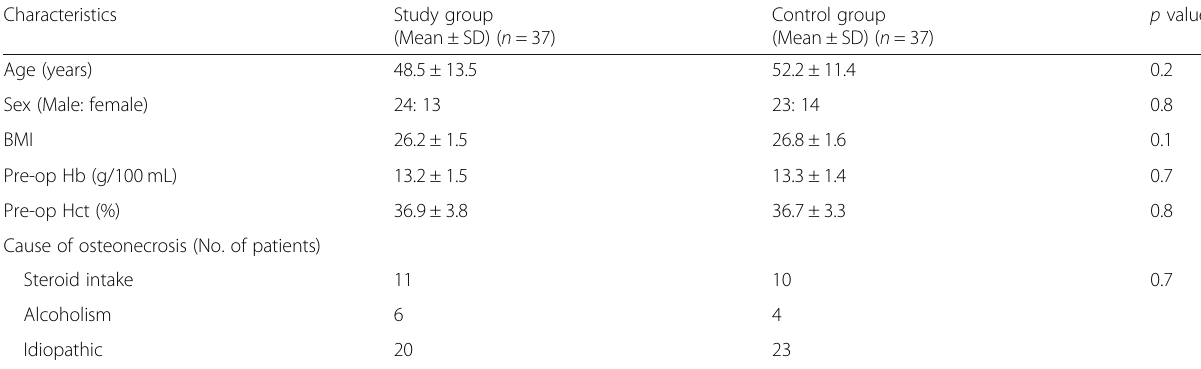
Table 1 Patient demographics and preoperative characteristics Characteristics